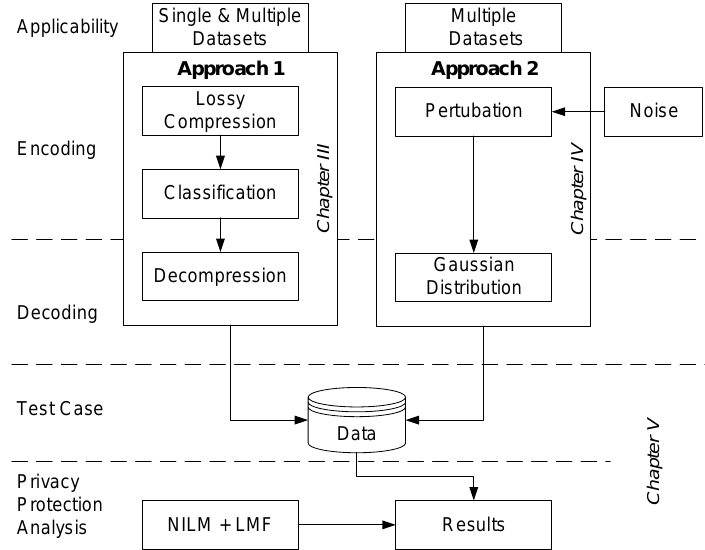
Figure 1. Proposed framework and approach of the